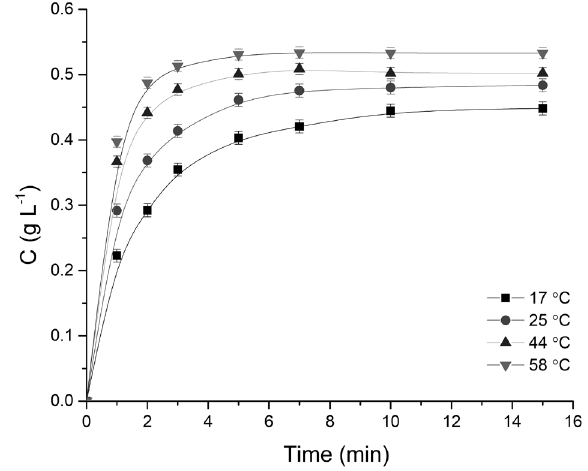
Figure 2: The kinetic curves of caffeine extraction from guarana seed under the action of UESC (Results are presented as means ± standard